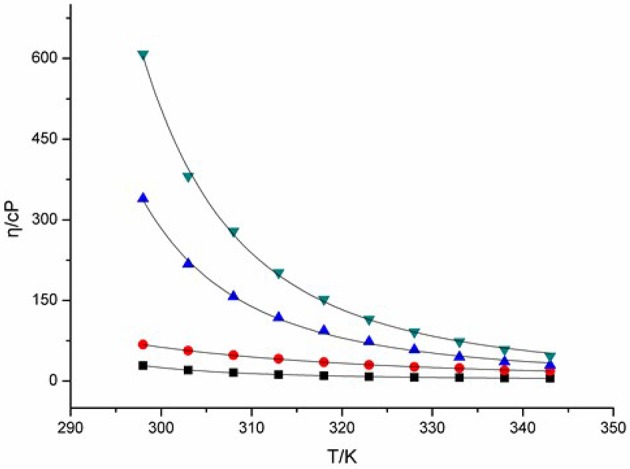
Viscosities (η) of [C4mim][N(CN)2] (black), [C4m2im][N(CN)2] (red), N4442[N(CN)2] (blue), and N8444[N(CN)2] (green) at different temperatures.